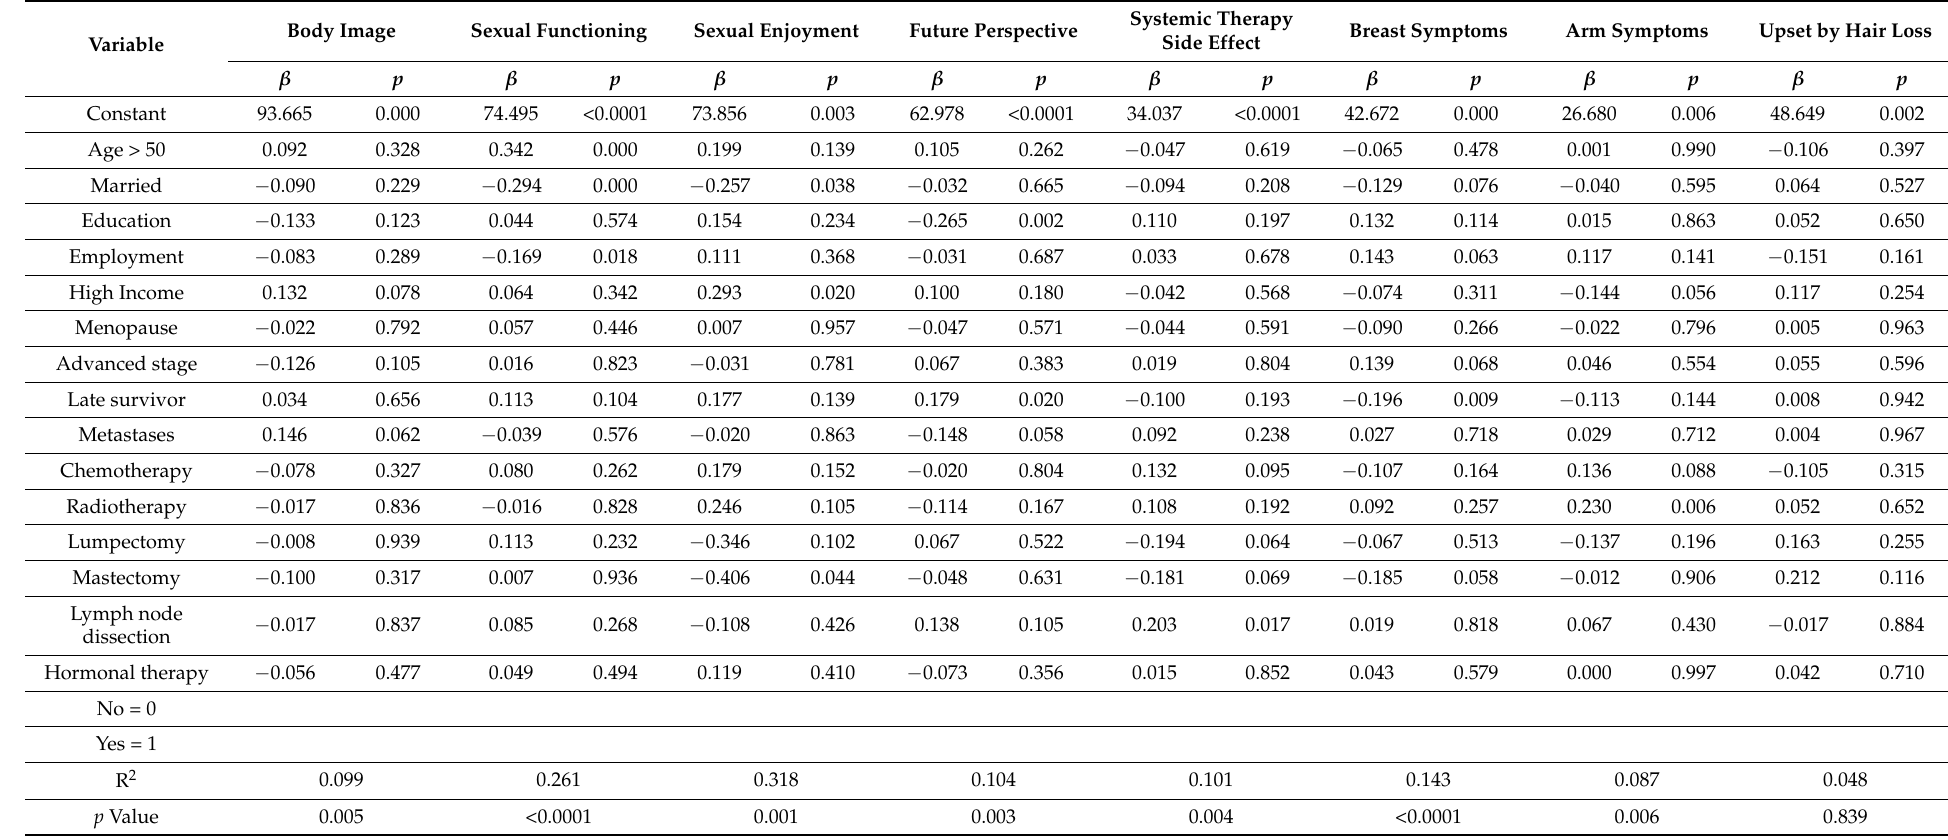
Table A2. Linear regression model with parameter estimates for the QLQ − BR23 functional and symptom